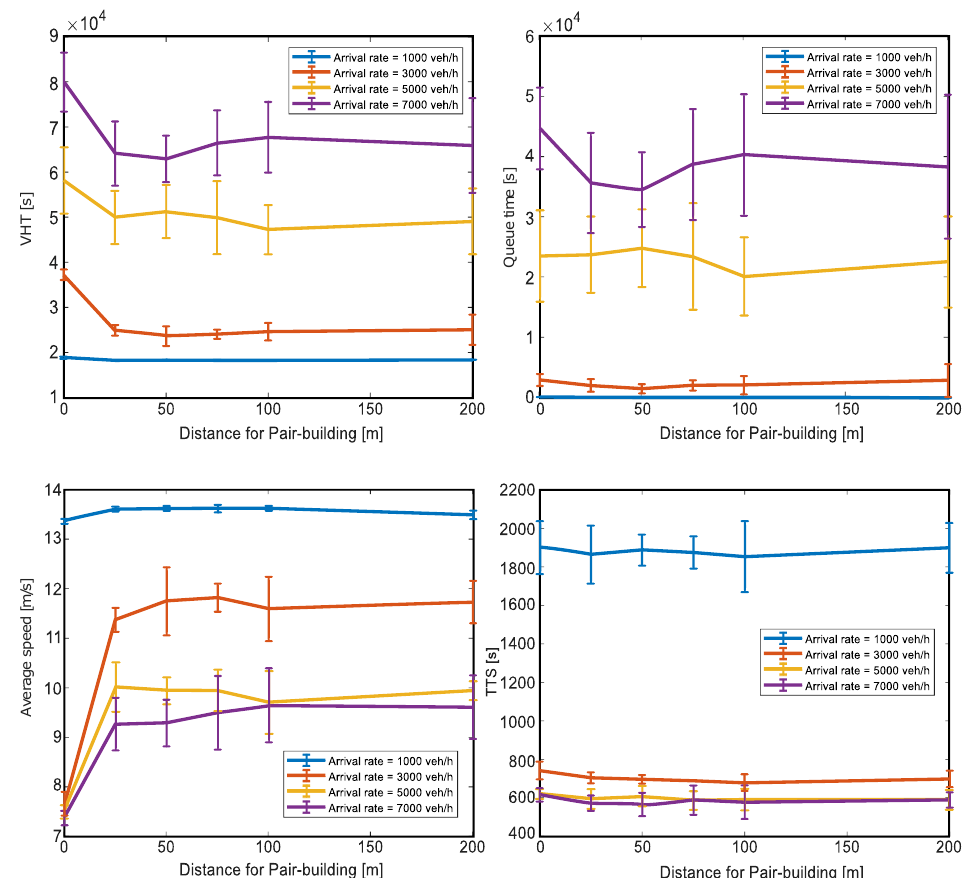
Figure 10. Simulation results for pairing region and catch-up sensitivity